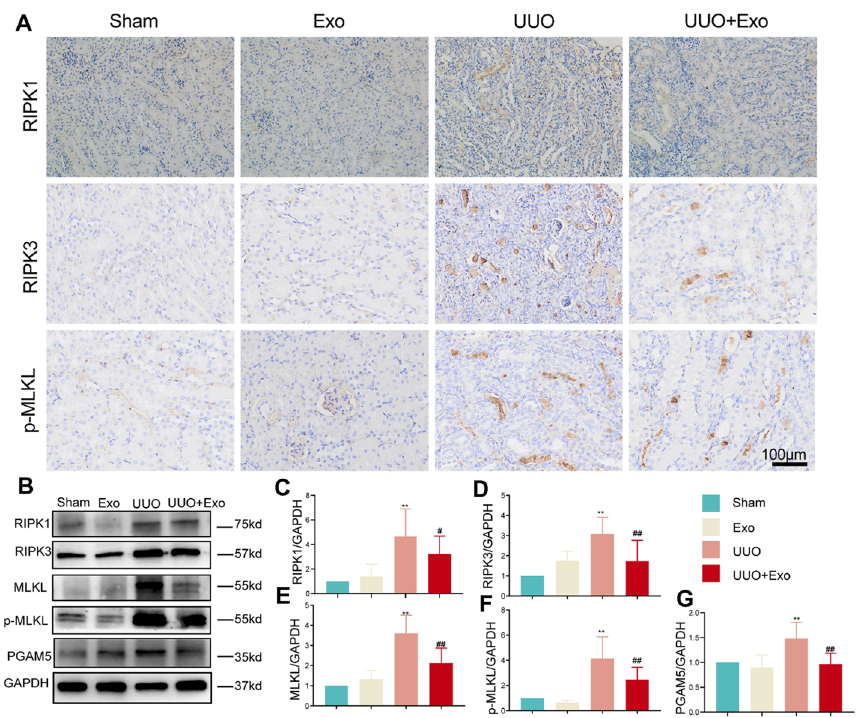
Fig. 3 Examination of necroptosis-related markers in four groups in vivo. A Immunohistochemistry detected of necroptosis-related markers (RIPK1, RIPK3, and p-MLKL) in each group. B Western blot of necroptosis-related markers (RIPK1, RIPK3, MLKL, p-MLKL, and PGAM5) in each group. C – G Relative expression of necroptosis-related markers detected by western blot. * p < 0.05, ** p < 0.01, compared with sham group; # p < 0.05, ## p < 0.01, compared with UUO